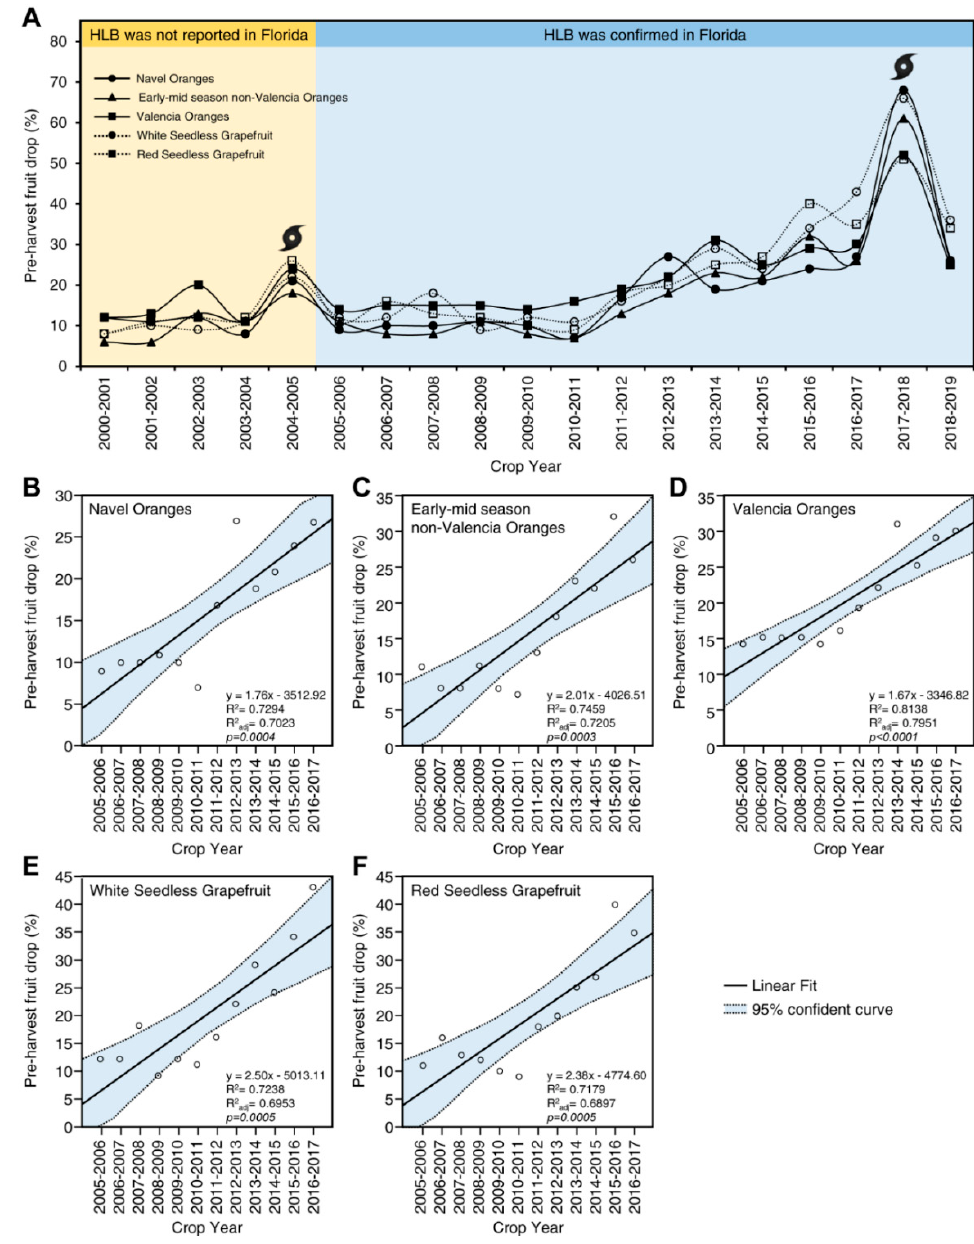
Figure 4. Preharvest fruit drop (%) from 2000 to 2019. ( A ) The fruit drop profile of five citrus groups including navel oranges, early-mid-season non-Valencia oranges, Valencia oranges, white, and red seedless grapefruits. The graph is based on the available information of citrus production reports in Florida from the USDA’s National Agricultural Statistics Service (NASS, 2019) available at https://www.nass.usda.gov/StatisticsbyState/Florida/Publications/Citrus/Citrus_Forecast/history.php. The dramatic increase in fruit drop during the 2004–2005 season was mainly due to the 2004 Atlantic hurricane season (Hurricane Charley, Hurricane Frances, Hurricane Ivan, and Hurricane Jeanne), whereas the high fruit drop during 2017–2018 season was due to the high winds of Hurricane Irma in September 2017. ( B – F ) Simple linear regression between crop season and preharvest fruit drop (%) of five citrus groups including navel oranges, early-mid-season non-Valencia oranges, Valencia oranges, white seedless grapefruits, and red seedless grapefruits, respectively. Dots present data on citrus production in Florida from the USDA’s NASS. The fitted regression line is presented as a solid line. The 95% confidence curve for the estimated linear regression is light-blue-shaded and edged by dotted lines. Regression equation, R 2 , R 2adj , and p -values were also obtained and are presented in the lower right corner of the graph.